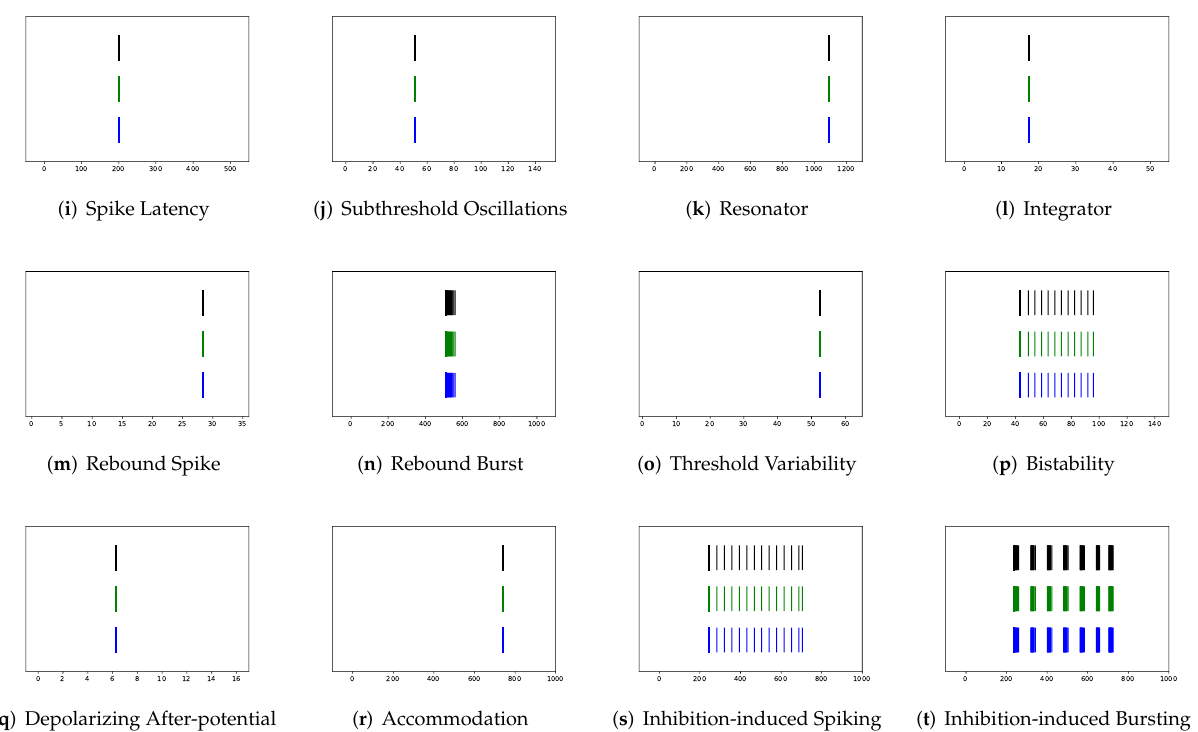
Figure 3. Spike trains of Izhikevich Model (black) vs. unmodified SRM (green) vs. modified SRM by maximum tolerance (blue), where x-axis is the time (ms).